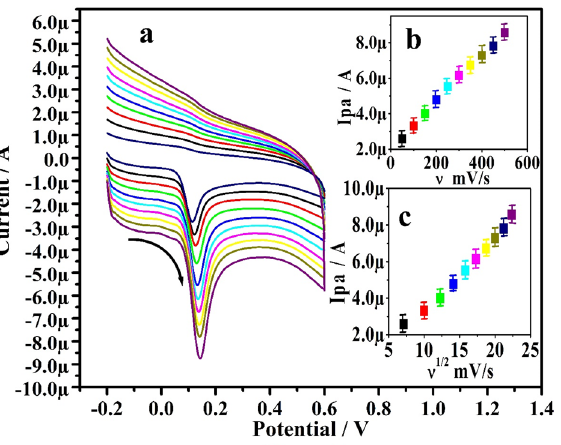
Figure 7. ( a ) CVs documented for ADR (10 µM) in 0.2 M PBS (7.4 pH) at Po-ERY/MGPE with various scan rate (50–500 mVs −1 ). ( b ) Graph of Ipa Vs scan rate of ADR (10 µM) in 0.2 M PBS (7.4pH). ( c ) Graph of Ipa Vs square root of scan rate of ADR (10 µM) in 0.2 M PBS (7.4pH).